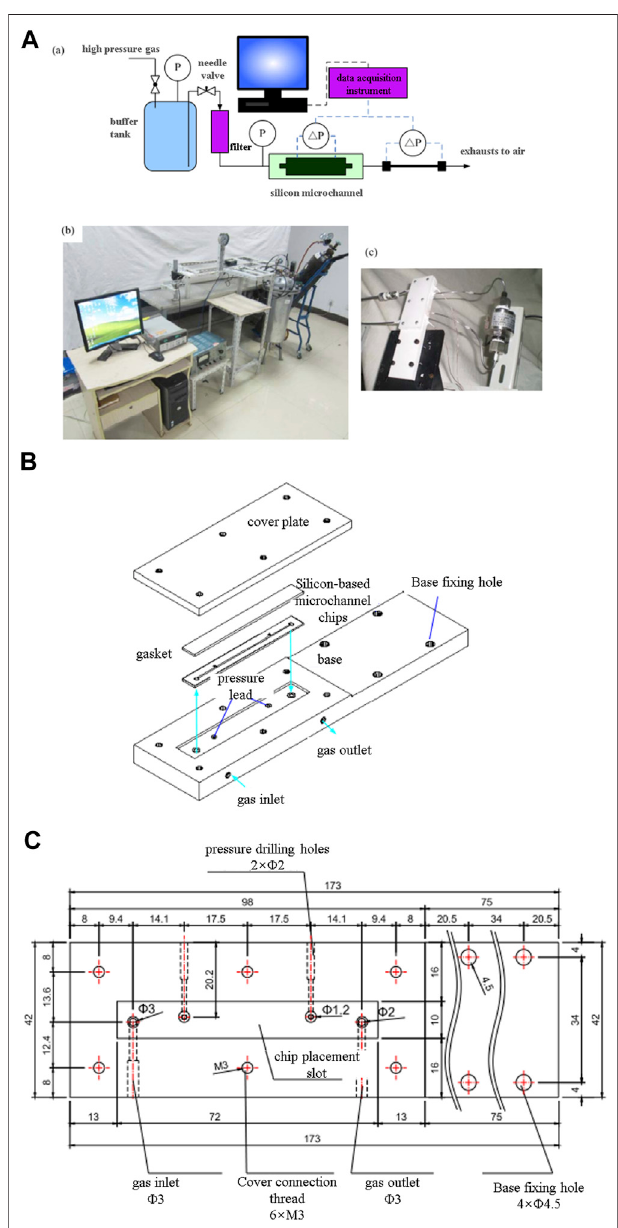
FIGURE2| Experimental systemofgas fl owinroughmicrochannel. (A) : (a) schematicdiagram, (b) physicalphotograph,and (c) experimentalsection. (B) Schematic diagram of the test section. (C) Microchannel base geometry size.